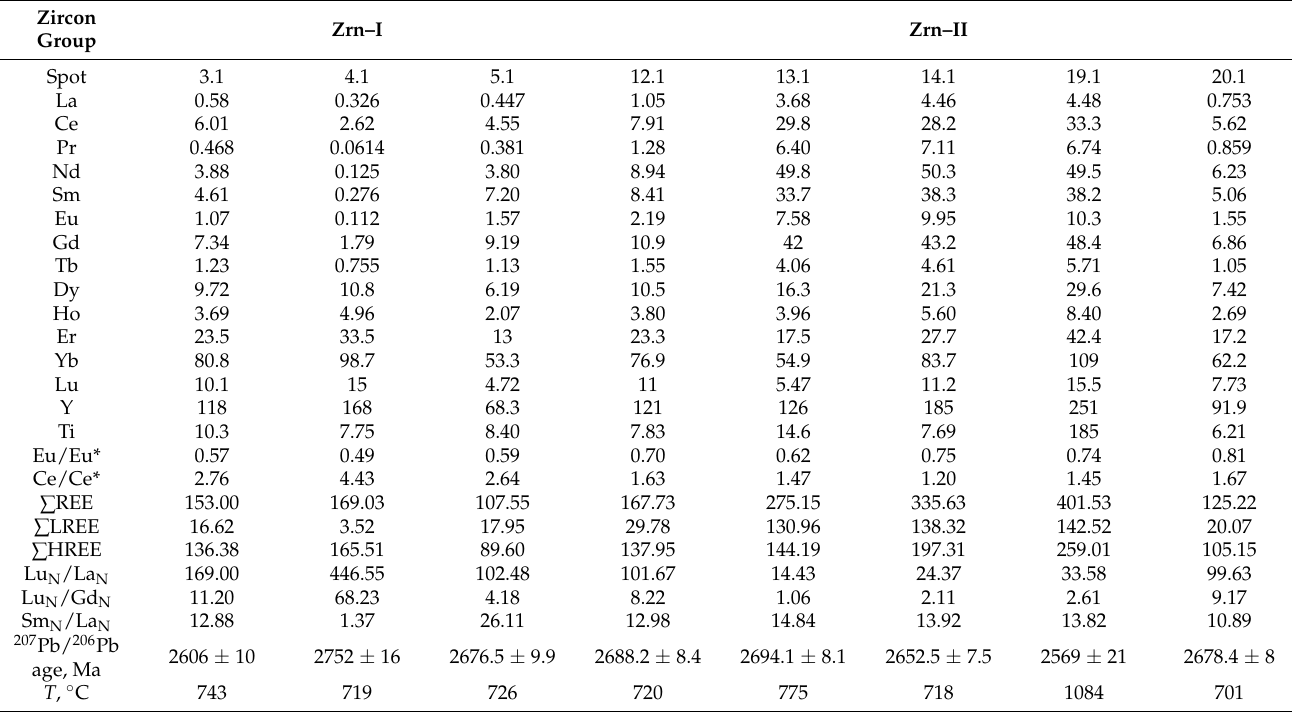
Table 2. Trace element concentrations (ppm) and element ratios in and crystallization temperatures of zircons from massive eclogite ST-2D.